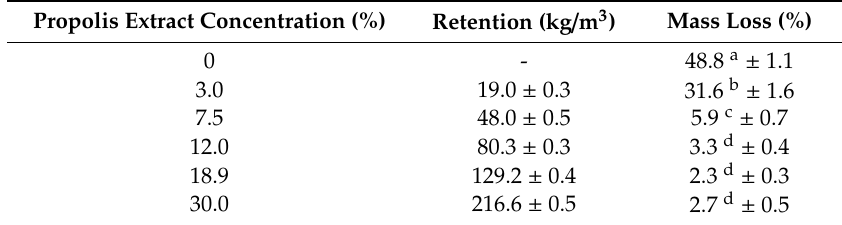
Table 1. Retention and mass loss of treated wood after exposure to C. puteana